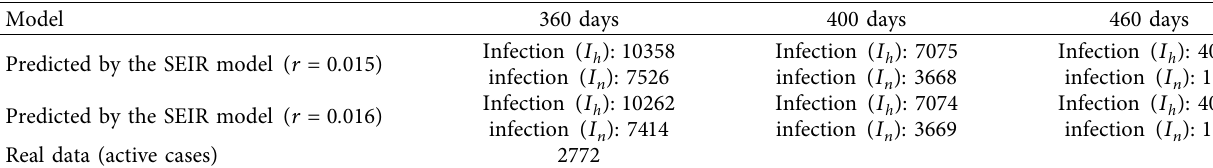
Table 8: Outbreak prediction of confirmed cases per